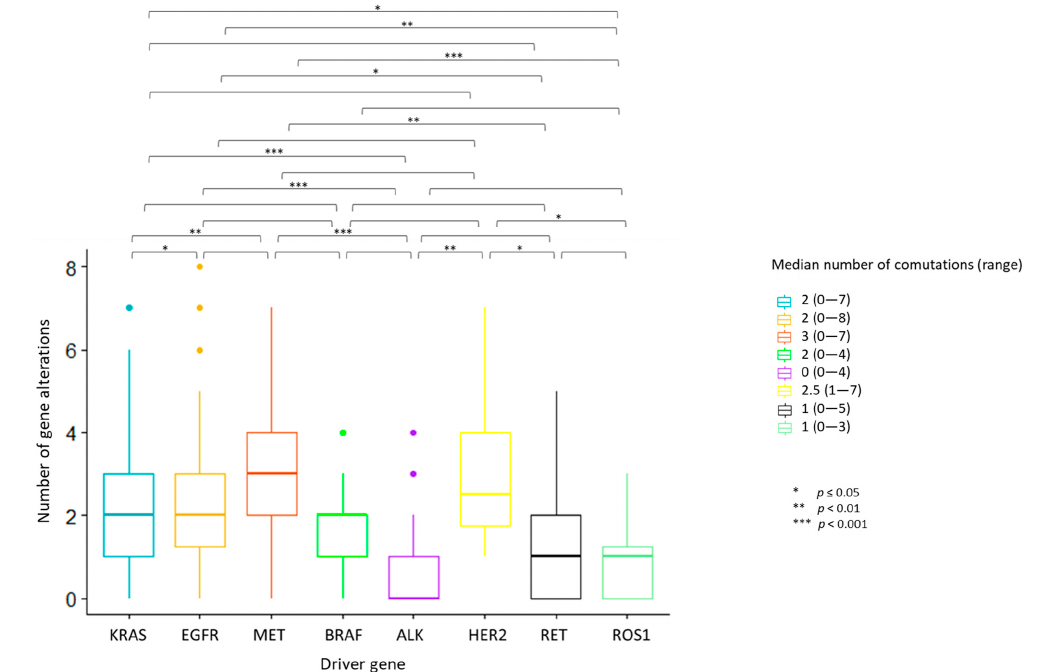
Figure 2. Number of concurrent gene alterations across the eight actionable gene groups. Each bar represents the number of concurrent gene alterations across the eight actionable gene groups. The median number and the range of concurrent gene alterations identified in each actionable gene group are reported in the legend on the right. Statistically significant differences in the distribution of the median number of total concurrent alterations were seen across the actionable gene groups, with the highest median number of concurrent alterations identified in MET deregulated tumors. ALK, ROS1 and RET-positive tumors displayed the lowest median number of co-occurrences. One-way ANOVA test for variance analysis. * p ≤ 0.05; ** p < 0.01; *** p <